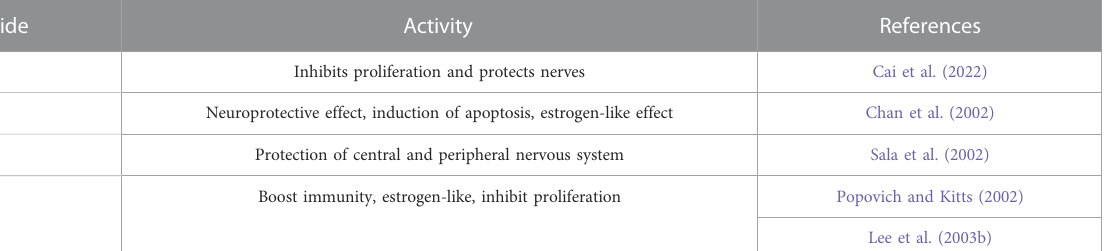
TABLE 3 Pharmacological activity of PPT type ginsenosides.